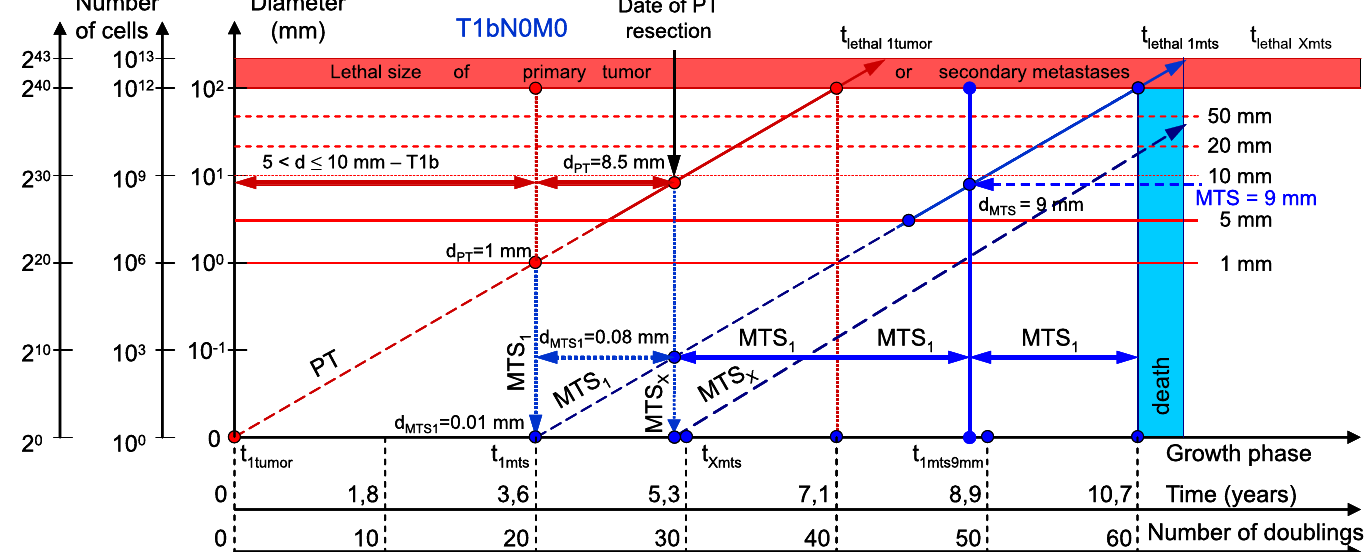
Fig 4. T1bN0M0. The whole natural history of PT and secondary distant MTS of patients without lymph nodes MTS via CoMPaS. Parameter T1b: 5 mm < d (cid:20) 10 mm. Diameter of PT at surgery of PT: d PT = 8.5 mm. Diameter of secondary distant MTS at surgery of PT: d MTS = 0.08 mm.